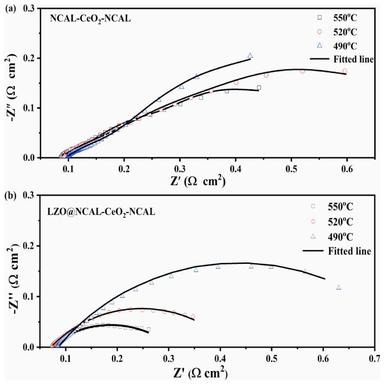
Electrochemical impedance spectroscopy (EIS) results for two different materials at (a) NCAL/CeO2/NCAL, (b) LZO@NCAL/CeO2/NCAL tested at different temperatures in fuel cell condition.